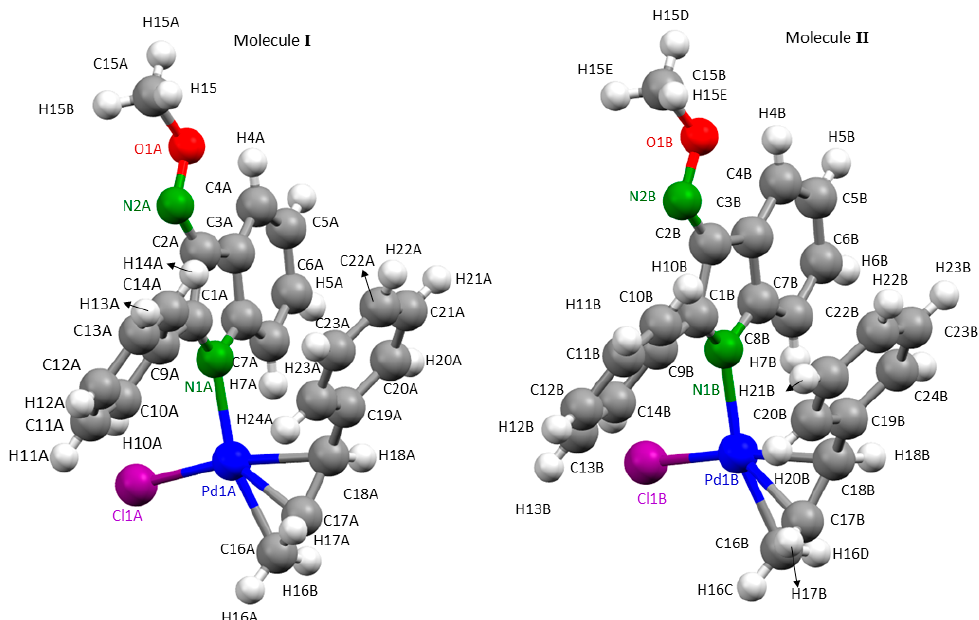
Figure 6. In both molecules the Pd(II) atoms are bound to a chlorido {Cl1A or Cl1B}, the substituted allylic ligand in a η 3 - fashion and the nitrogen of the indole ligand (N1A and N1B in I and II , respectively). Catalysts 2019 , 9 , x FOR PEER REVIEW